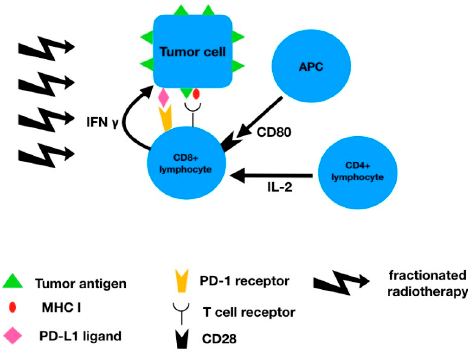
Figure 1. Connection of radiotherapy and PD-L1 expression.